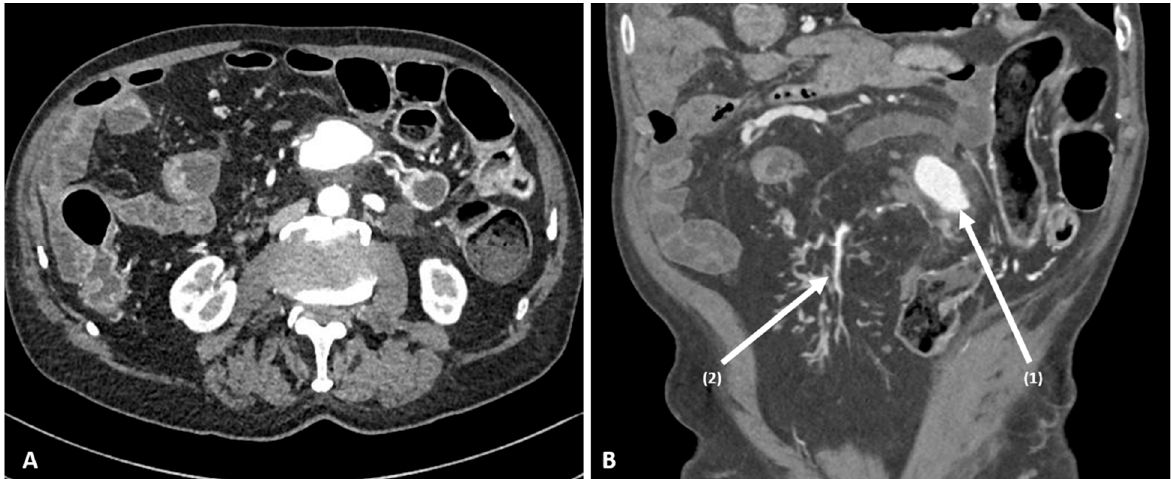
Figure 1. Computed tomography enterography (CTE) showing the jejunal artery (JA) pseudoaneurysm measuring 53 × 47 × 25mm. ( A ) Axial image demonstrating the inflow and outflow arteries. ( B ) Coronal image displaying the aneurysm inside the small-bowel mesentery (arrow 1) and the relationship with the superior mesenteric artery (SMA) (arrow 2).